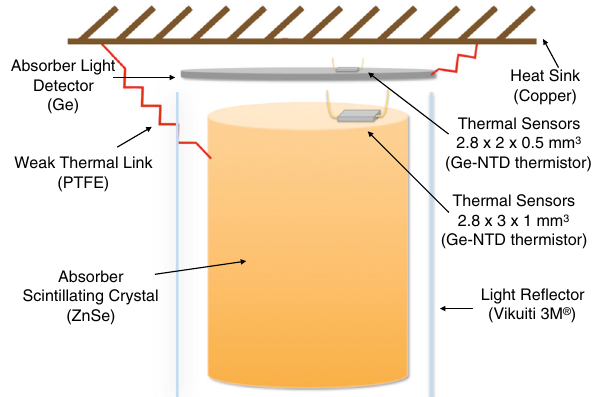
Fig. 1 Schematic view of a single module scintillating bolometer